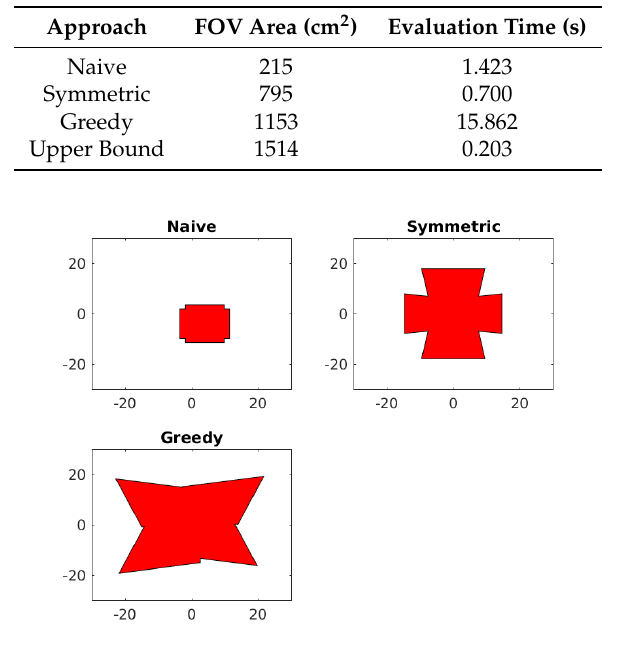
Table 2. Results of Maximal Area Optimization on Grid Array.